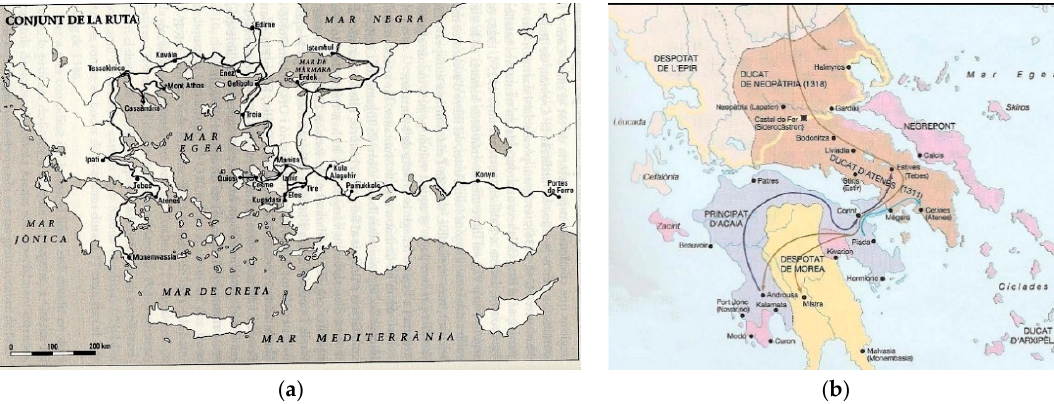
Figure 13. The Catalans in Greece and Anatolia. ( a ) Itinerary of the Grand Catalan Company (Almogàvers) (1303–1311). Source: (Nicolau d’Olwer 1974) ( b ) Catalan Greece in 14th century: Duchies of Athens and Neopatras. Source: (Hurtado et al. 1995).